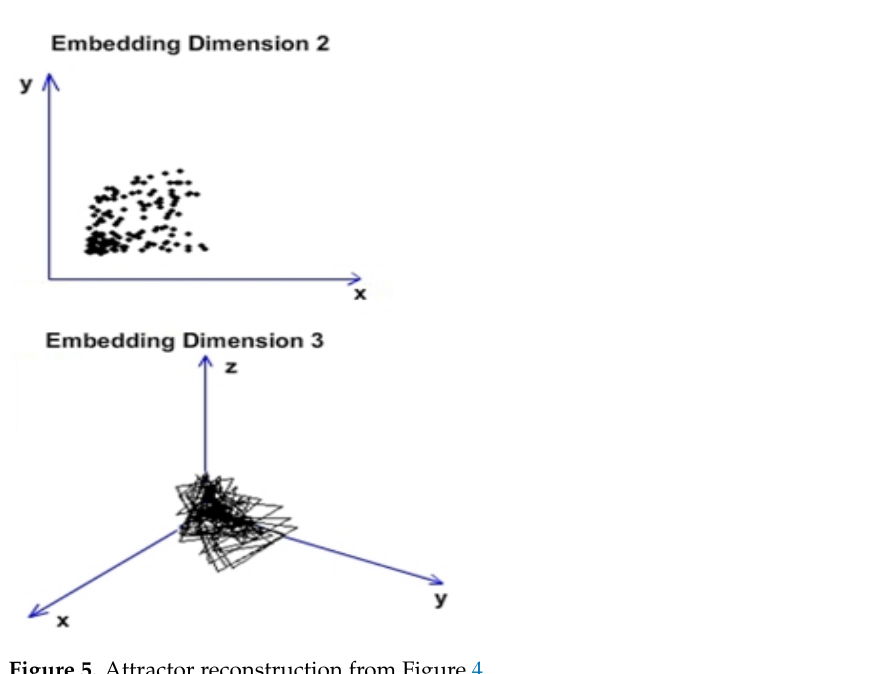
Figure 4. The selection of the modified area.